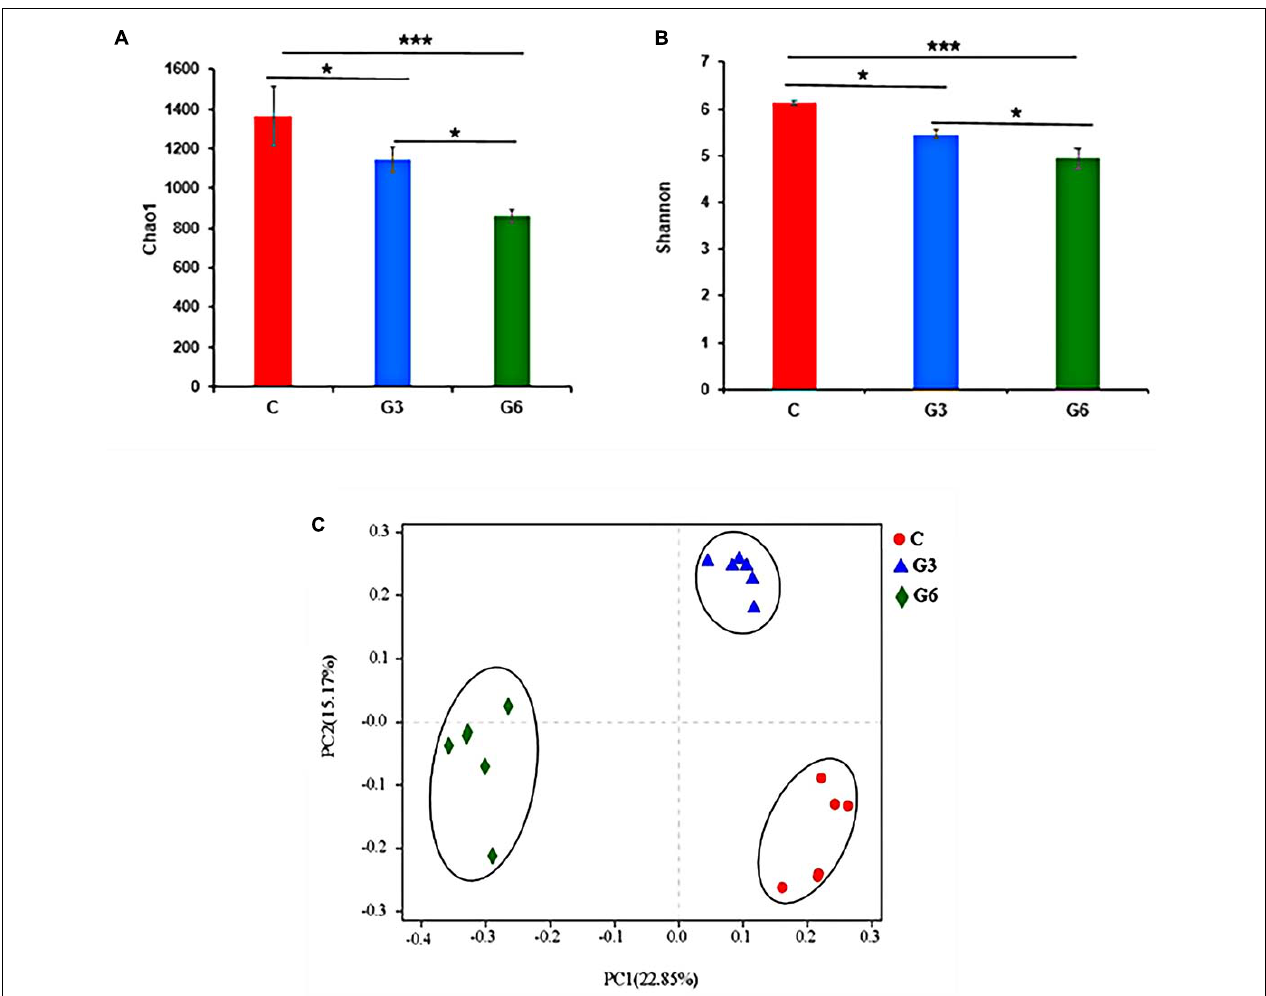
FIGURE 1 | Bacterial diversity. (A,B) Alpha diversity metrics (A) Chao 1 and (B) Shannon for the rumen microbiota of grass-fed (C), grain-fed for 3 months (G3), and grain-fed for 6 months (G6) yaks. (C) The plot of Principal coordinate analysis (PCoA). The closer distance between the sample points means the higher similarity of the bacteria. * p < 0.05; *** p <